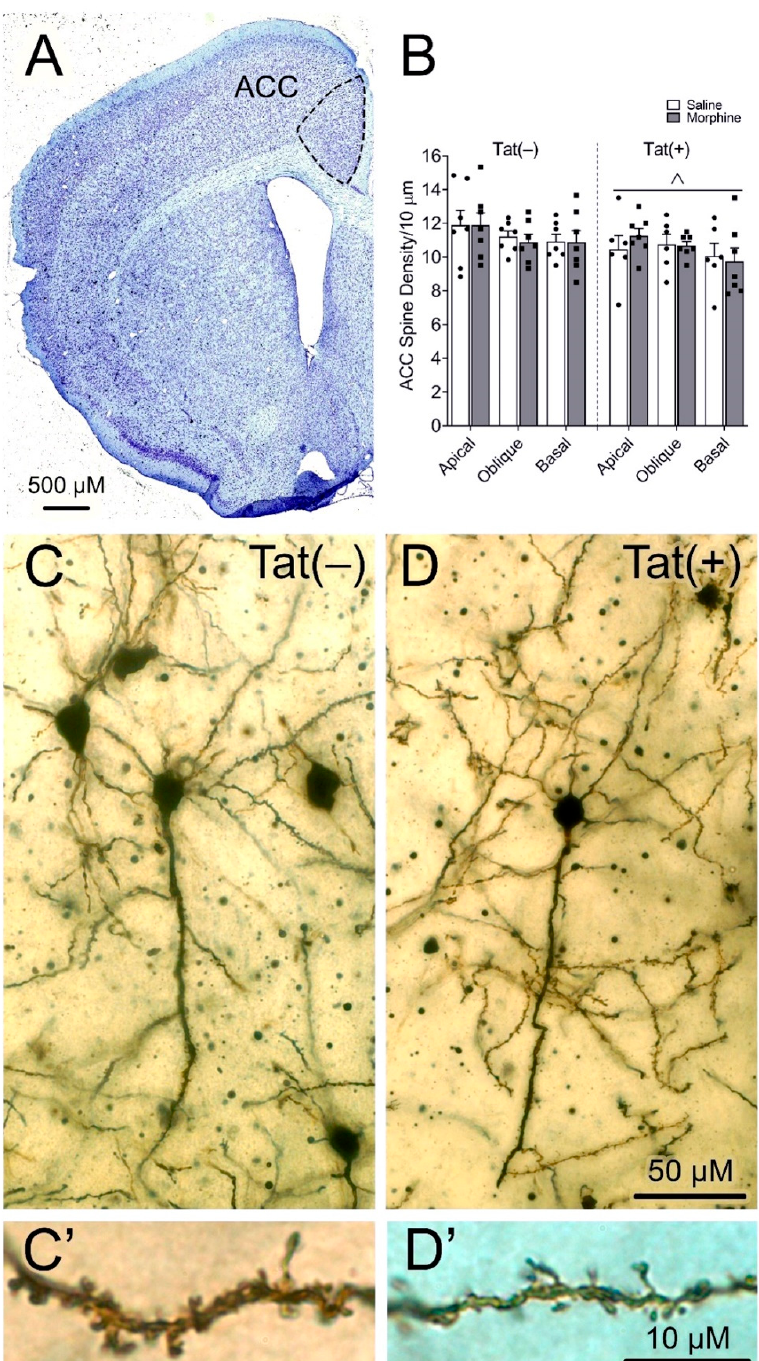
Figure 7. HIV-1 Tat, but not morphine, decreases layer V pyramidal neuron dendritic spine density within the anterior cingulate cortex (ACC). Representative Nissl-stained image of the ACC region of the prefrontal cortex (PFC) (scale bar = 500 µ M) ( A ). Tat decreased dendritic spine density across apical, oblique, and basal dendrites irrespective of morphine treatment ( B ). Representative lower magnification images of Golgi-impregnated layer V pyramidal neurons (scale bar = 50 µ M) in saline- treated Tat(–) ( C ) and Tat(+) ( D ) mice. Higher magnification images illustrating dendritic spines in saline-treated Tat(–) ( C’ ) and Tat(+) ( D’ ) mice (scale bar = 10 µ M). Data are presented as the mean ± the SEM; multiple neurons ( ≥ 6) were sampled from each mouse; n = 6–7 mice per group; ˆ p < 0.05, the main effect of